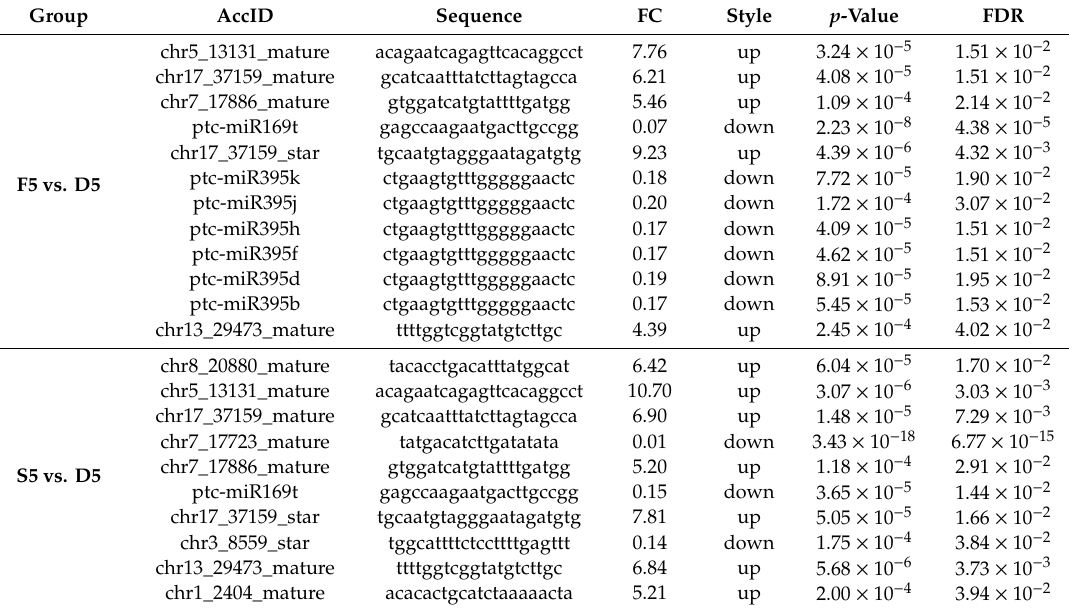
Table 1. Di ff erentially expressed microRNAs in allotriploid and diploid Populus . Group AccID Sequence